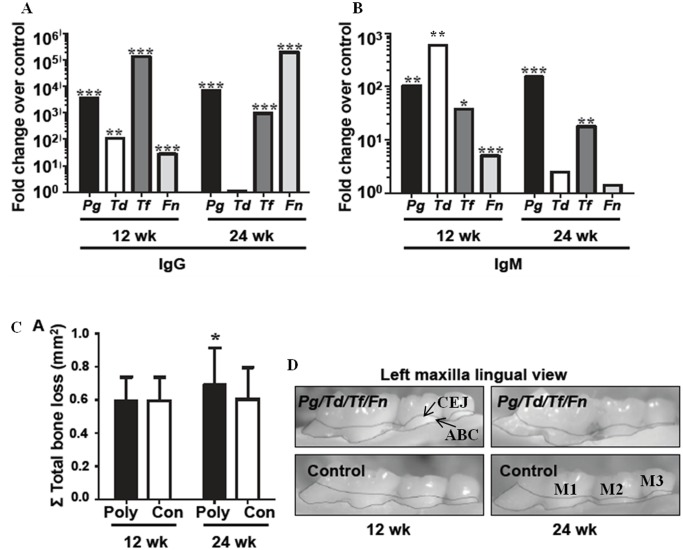
Polybacterial-infection induced bacterial-specific humoral immune response and alveolar bone resorption.(A). Serum IgG antibody response to the four bacteria used in periodontal infection at 12 and 24 weeks. (B). Serum IgM antibody response to the four bacteria used in periodontal infection at 12 and 24 weeks. (C). Total alveolar bone resorption is significantly greater than controls at 24 weeks of polybacterial infection. (D). Representative left maxilla lingual view of polybacterial-infected and sham-infected mice at both 12- and 24 weeks with area of bone resorption outlined from alveolar bone crest to cementoenamel junction. Poly—polybacterial infection, Con—sham-infected control, Pg/Td/Tf/Fn–polybacterial infection Pg–P. gingivalis, Td–T. denticola, Tf–T. forsythia, Fn–F. nucleatum. * p < 0.05, ** p < 0.01, *** p < 0.001.